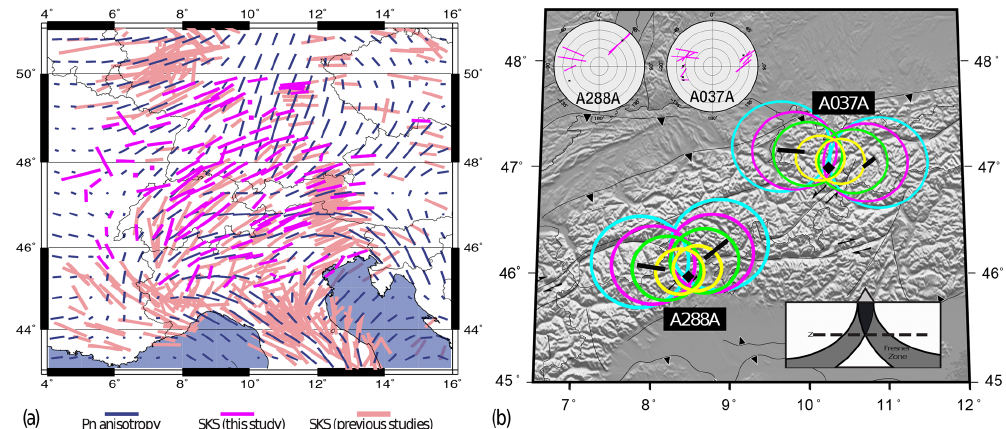
Figure 6. (a) Comparison between our SKS measurements (red bars), Pn anisotropy axes (Diaz et al., 2012, and references therein), and previous SKS measurements. (b) Single-station Fresnel analysis of SKS observations at two AlpArray seismic stations from two earthquakes from opposing directions. Coloured circles show the approximate Fresnel zone for the SKS wave at different depths: 50km (yellow), 100km (green), 150km (magenta), and 200km (cyan). Black lines show the SKS fast-axis direction projected at its 150km piercing point. Top left insets: polar plots for all measurements available for the two stations. Bottom right inset: cross section of the Fresnel zones of two incoming SKS waves from opposing directions and the depth where these zones overlap (after Alsina and Snieder, 1995).